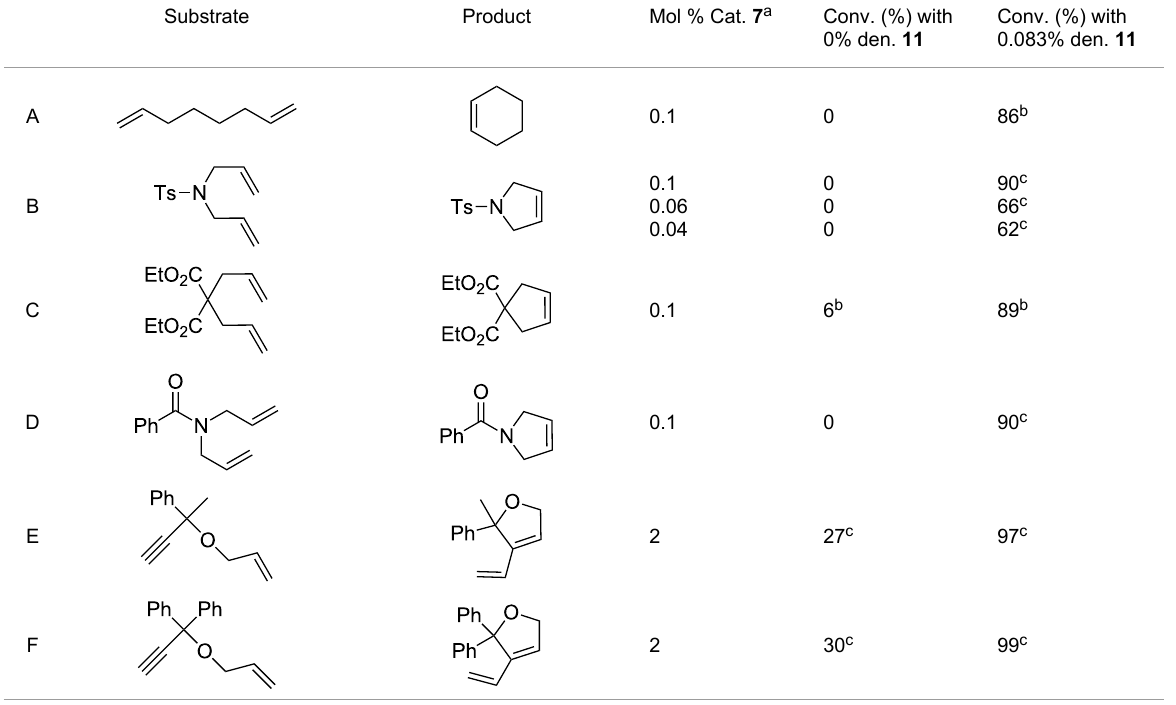
Conv. (%) with 0% den. 11 0.083% den. 11